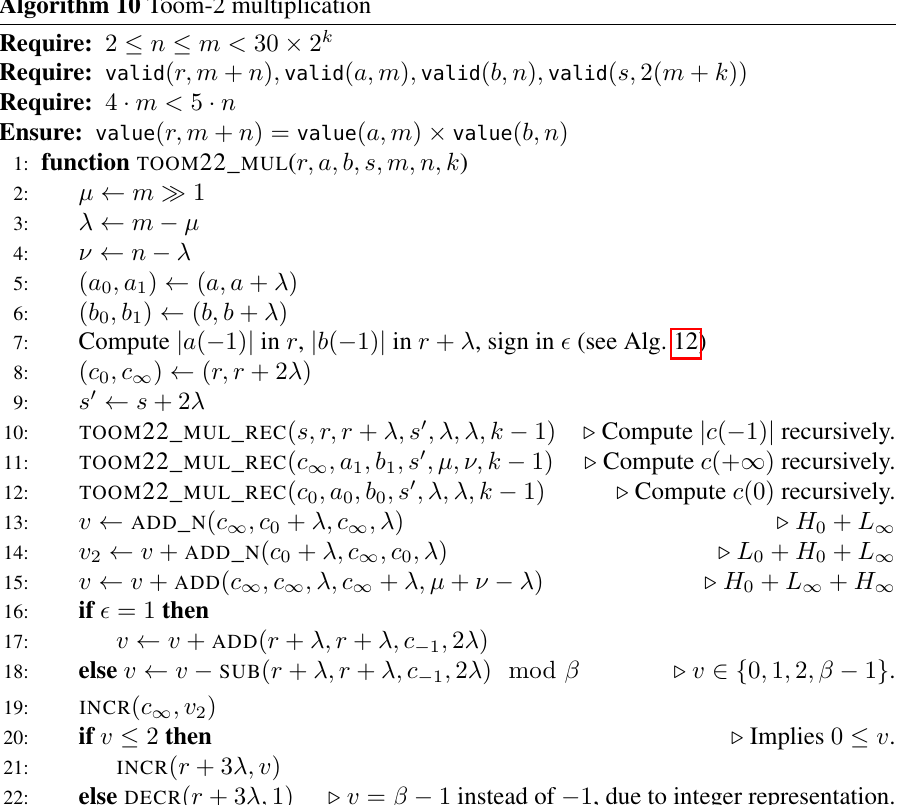
Algorithm 10 Toom-2